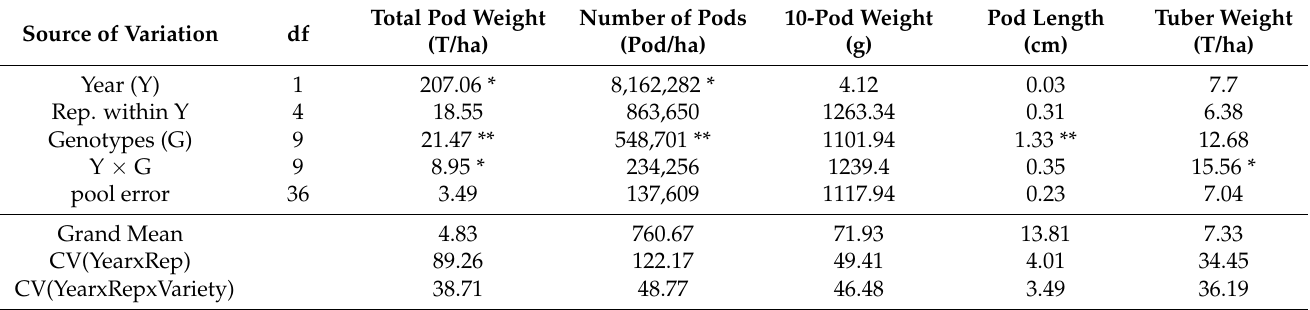
effect on total pod weight and tuber weight at a 95% confidence level (Table 1). Our results found significant effects upon all traits, except 10-pod weight, due to its uniformity within the marketplace. Table 1. Mean squares of total pod weights, number of pods, 10-pod weights, pod lengths, and tuber weights of ten accessions evaluated across two years under rainy season conditions at Khon Kaen University in 2019 and 2020.